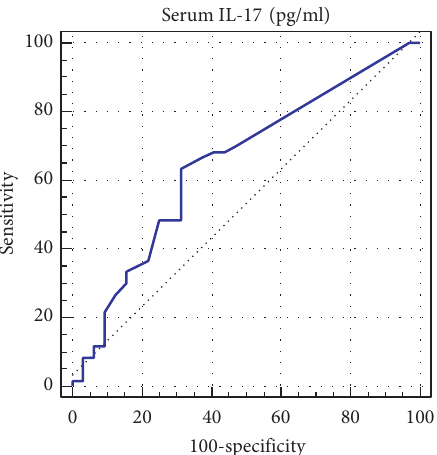
Figure 2: Area under the ROC curve analysis to determine the value of IL-17A in NMSC